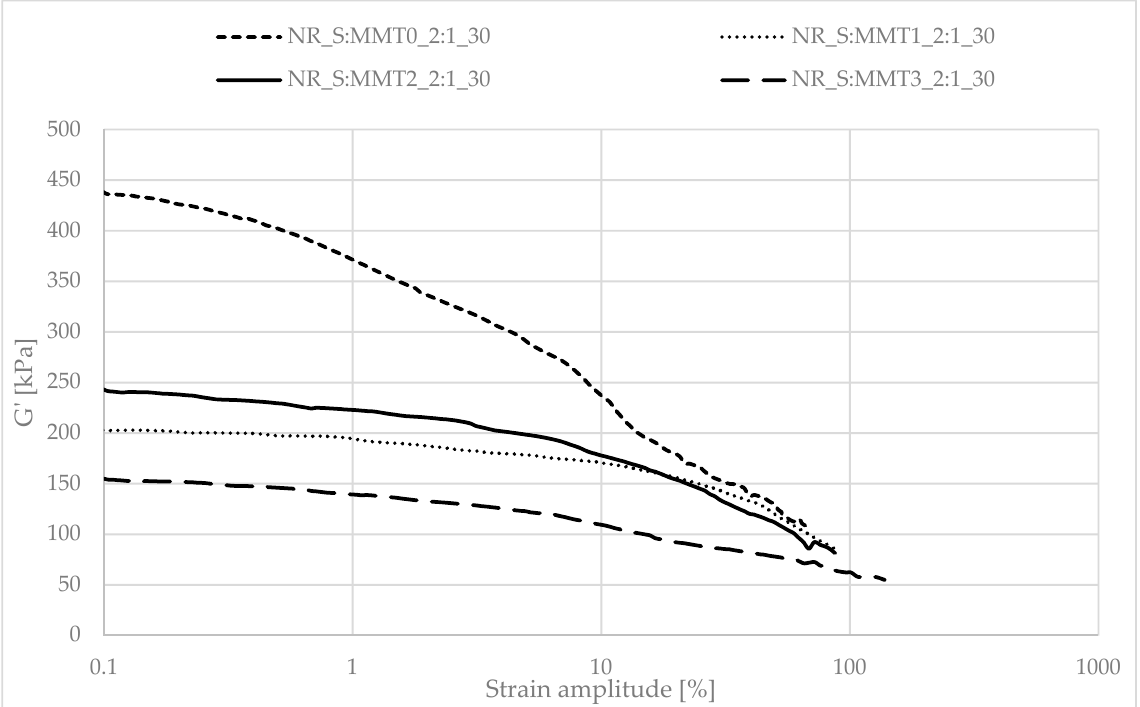
Figure 11. Dependence of the storage module as a function of the strain amplitude for natural rubber composites filled with straw:montmorillonite filler (30 phr), 2:1 ratio.